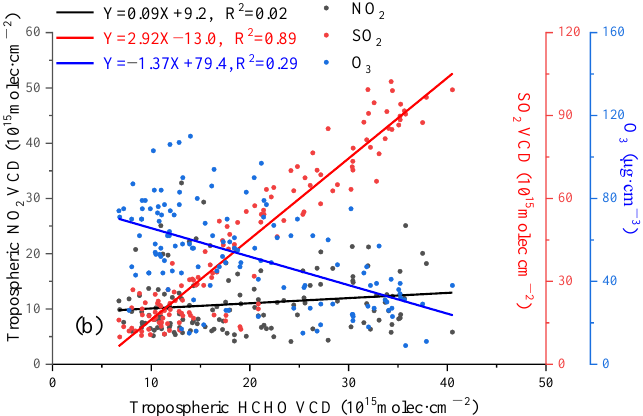
Figure 10. Scatter plots and linear regressions of daily average HCHO VCD measured by MAX-DOAS against NO 2 , SO 2 VCD measured by MAX-DOAS and O 3 measured by an in situ instrument in ( a ) 2020 and ( b ) 2021.